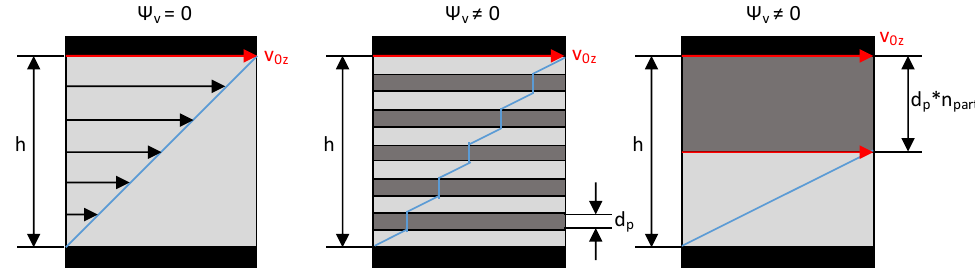
Figure 8. Schematic simplified representation of shear increase due to solid particles.